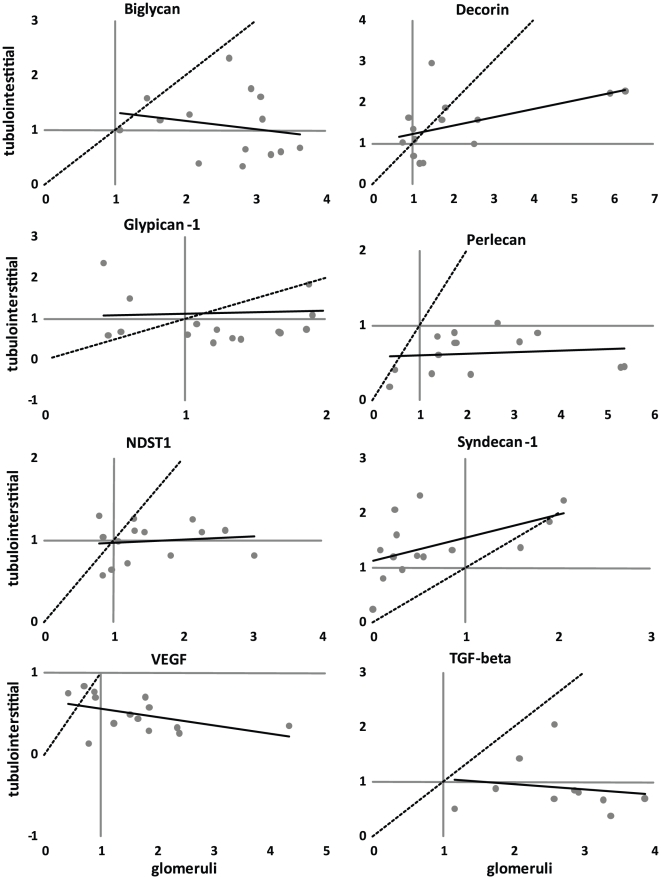
Relative gene expression in the tubulo-interstitium and the glomeruli.Microdissection makes it possible to plot the glomerular and tubulo-interstitial values against each other. The expected outcome of identical glomerular and tubulo-interstitial expression is shown as a dotted line. No correlations between tubular and glomerular gene expression were found, indicating that glomerular and tubulo-interstitial gene expression is independent of each other.